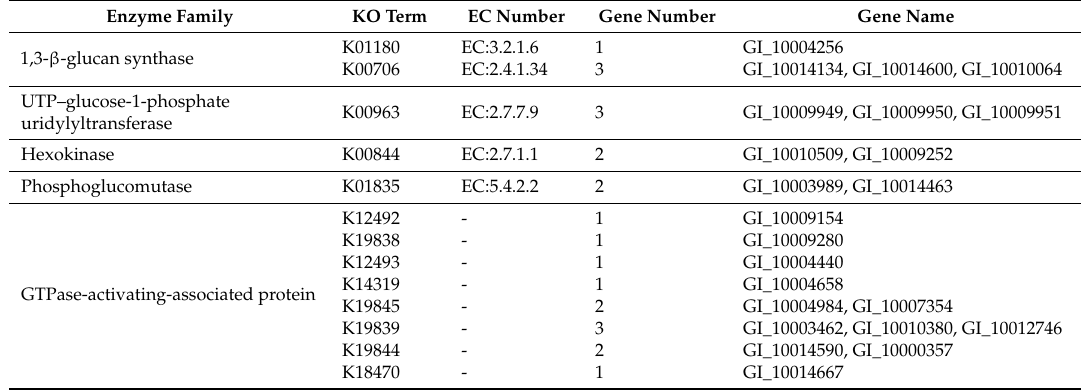
Table 3. Summary of the polysaccharide biosynthesis-related proteins in G. incarnatum . Enzyme Family